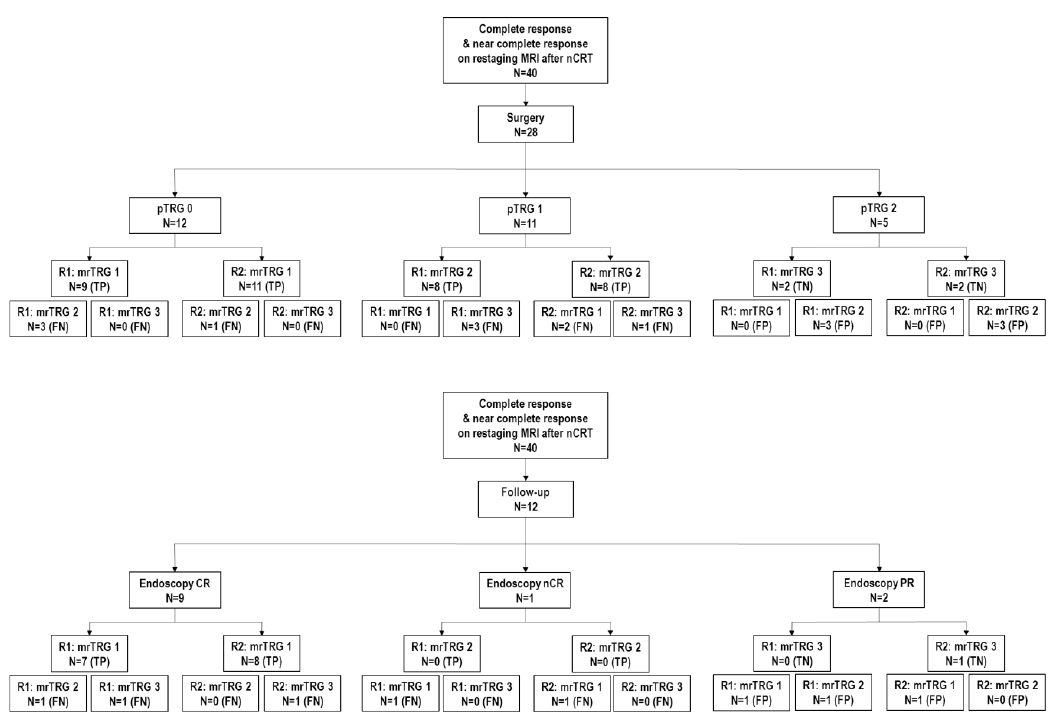
Figure 1. Flowchart of treatment and tumor assessments for included patients. nCRT = neoadjuvant chemoradiotherapy; pTRG = pathologic tumor regression grade; mrTRG = MRI tumor regression grade; TN = true negative; FP = false positive; TP = true positive; FN = false negative; CR = complete response; nCR = near-complete response; PR = partial response. A patient with CR at restaging MRI, confirmed by the histopathological report from surgery, is presented in Figure 2.